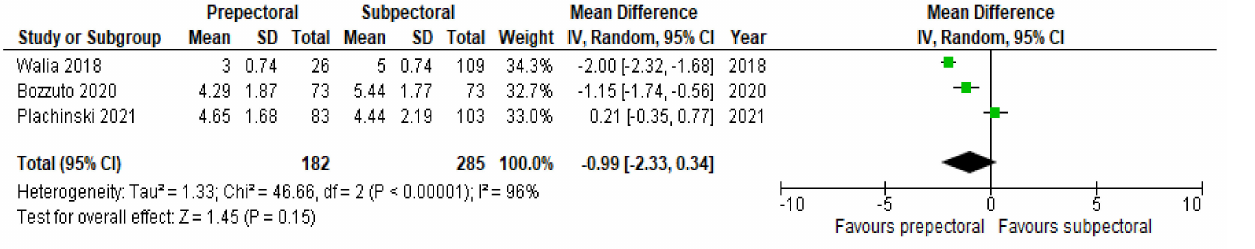
Figure 2. Postoperative pain